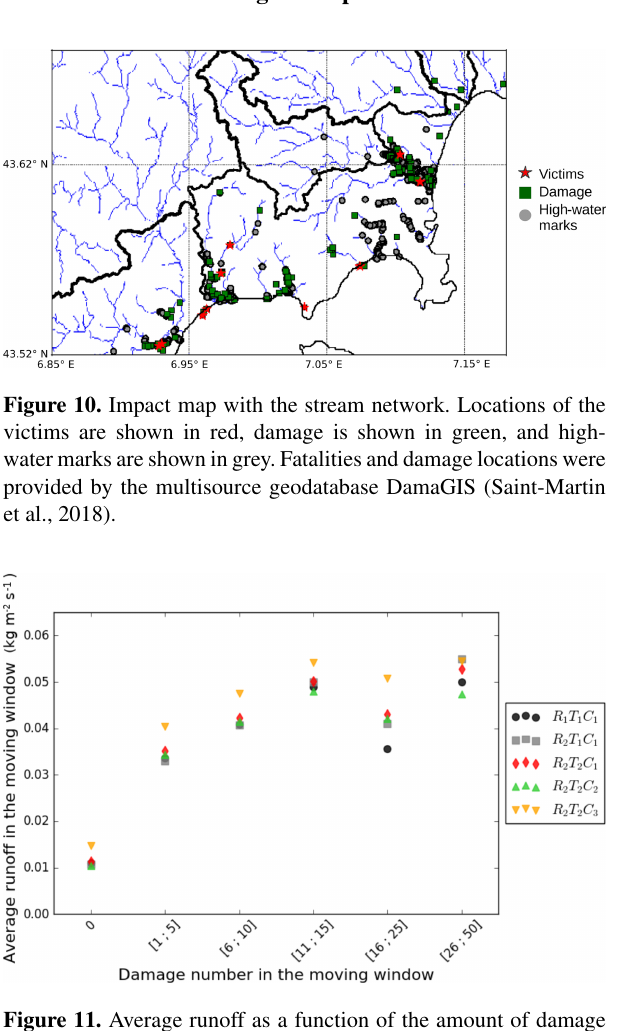
Figure 11. Average runoff as a function of the amount of damage encountered in the 1km circular neighbourhood over all the domain of Fig.